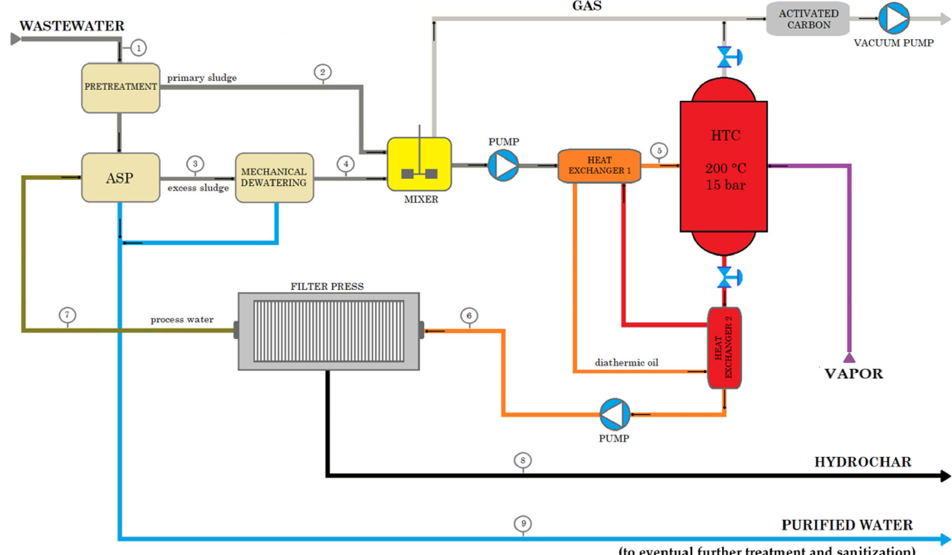
Figure 6. Block diagram of a WWTP with the on-site HTC treatment of sewage sludge. Table 5. Material and energy balances of the process schematically shown in Figure 1.